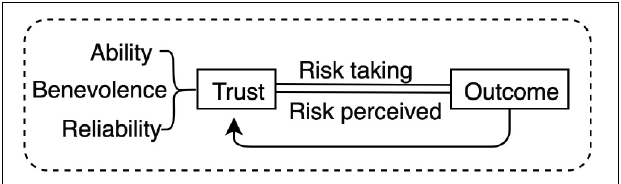
FIGURE 2 | Muir and Mayer model of trust as a function of the trustee’s ability, benevolence and reliability (1995) where risk perception affects risk action. This bipartition of trust as ability and benevolence amounts to two different levels in the motor hierarchy of the extended agent (e.g., the robot), whereby benevolence refers to the high-level goals motivating the extended agent and ability refers to the means of the agent to realize these goals, i.e., the sophistication of its low-level motor output in relation to the task at